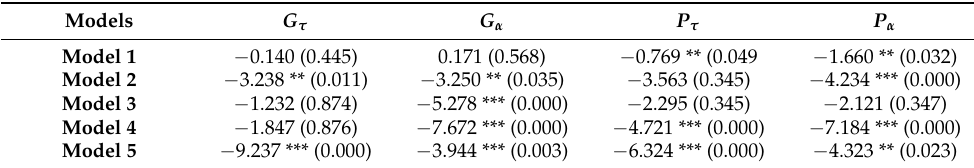
Table 5. Westerlund cointegration